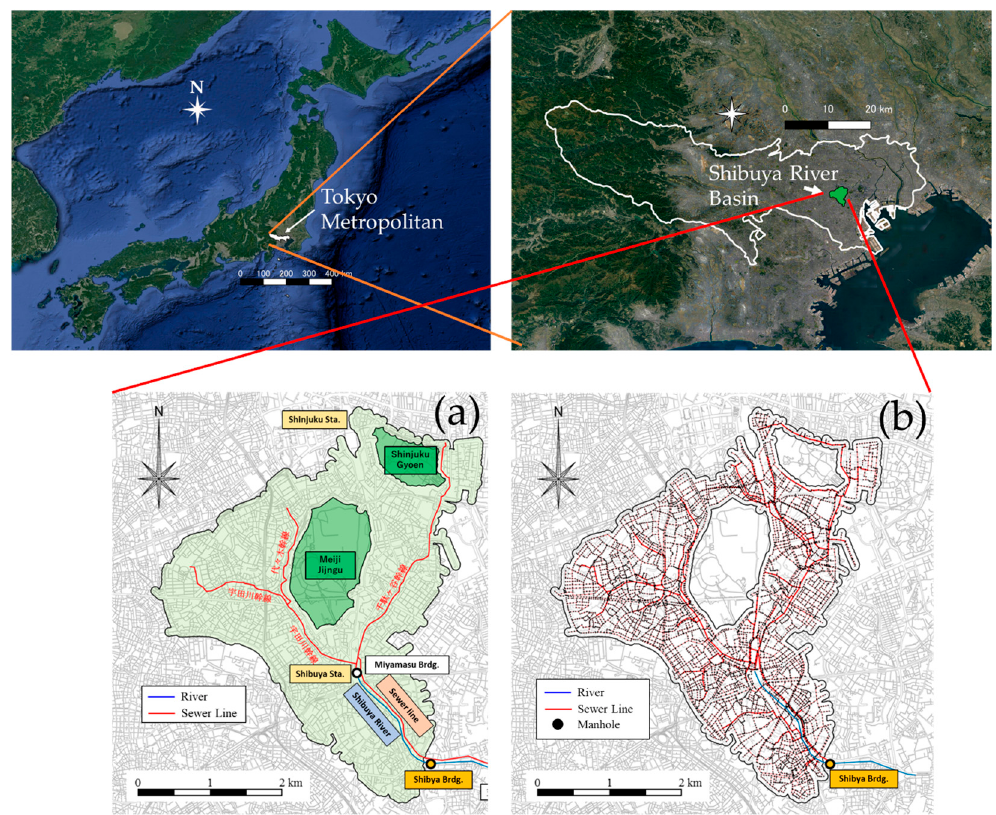
Figure 1. Location of the Study Area ( a ): Shibuya River Basin and ( b ): Pipeline Network. Next, the focal point is on torrential rainfall events caused by localized torrential rain. Figure 2 shows the localized torrential rain in Shibuya River Basin that occurred on May 18, 2017. Figure 2a shows Shibuya River under normal conditions. These photo- graphs show that the river carries little water under normal conditions, and the build- ings fill the area along the river right up to the embankment. Figure 2b shows the river during a flood. At the bottom of Figure 2 are the hyetograph and hydrograph at that time. These diagrams show that the time between the rainfall peak and the water level peak was ~30 min, showing the extremely fast flood arrival time. Therefore, urban ba- sins with a small area have a short flood arrival time, resulting in an extremely short lead time for residents to evacuate.